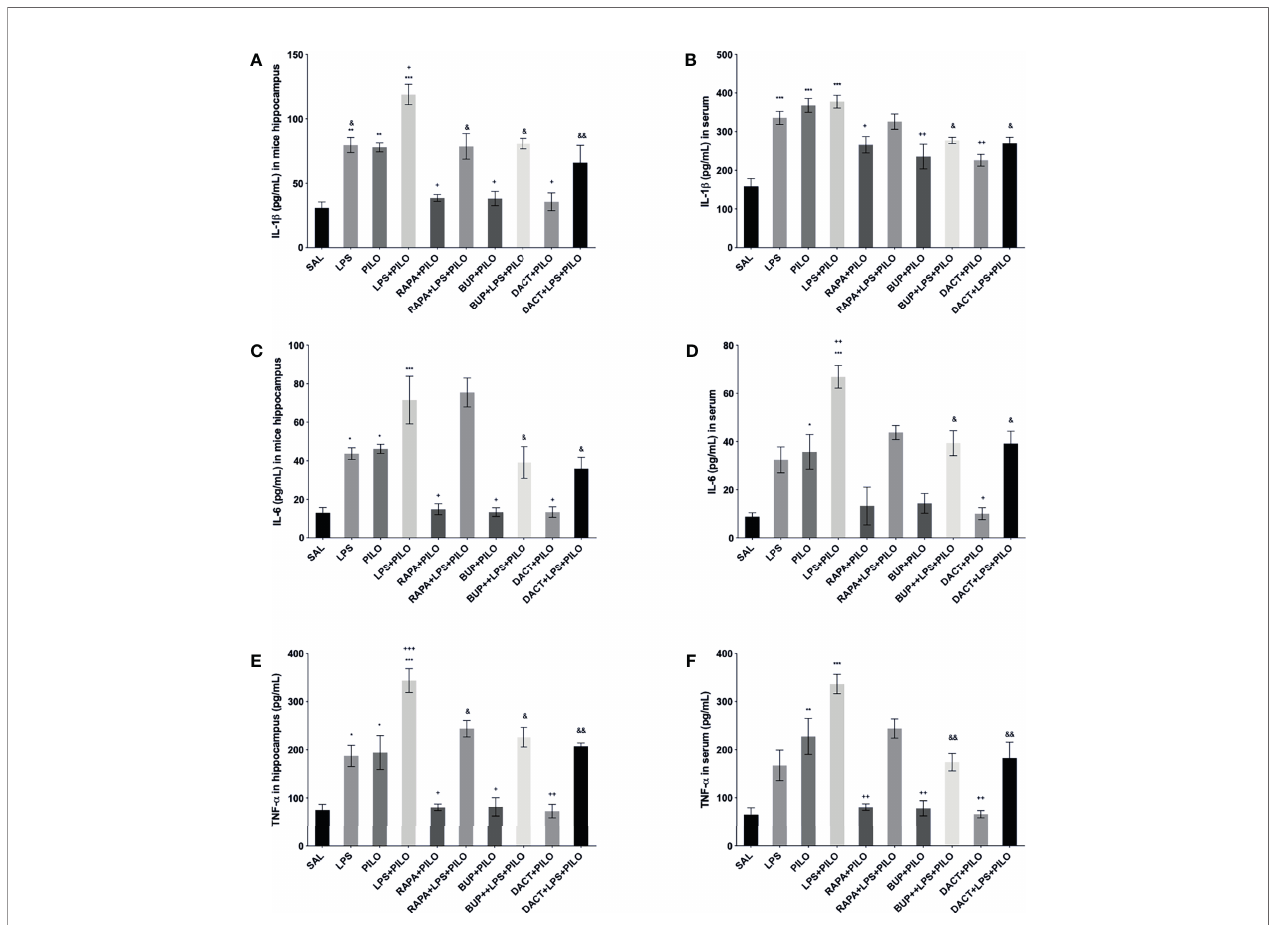
FIGURE 11 | Effects of the RAPA, BUP, and DACT on TNF- a , IL-1 b , and IL-6 levels (pg/ml) in LPS/PILO-treated C57BL/6 mice. The cytokine levels (pg/ml) in the above fi gure were measured in the in vivo hippocampal and serum samples of C57BL/6 mice. The fi gure is represented as effects on the levels of IL-6 (A) in vivo hippocampal samples and (B) serum samples. Effects on IL-1 b levels in (C) in vivo hippocampal samples and (D) serum samples. Effects on the TNF- a levels in (E) in vivo hippocampal samples and (F) serum samples. The data are represented as mean ± SEM (n = 3) and analyzed by one-way ANOVA followed by Tukey Kramer multiple comparison tests. ***p< 0.001 versus SAL, **p<0.01 versus SAL, *p<0.05 versus SAL, && p<0.01 versus LPS+PILO, & p<0.05 versus LPS+PILO, ++ p<0.01 versus PILO, and + p<0.05 versus